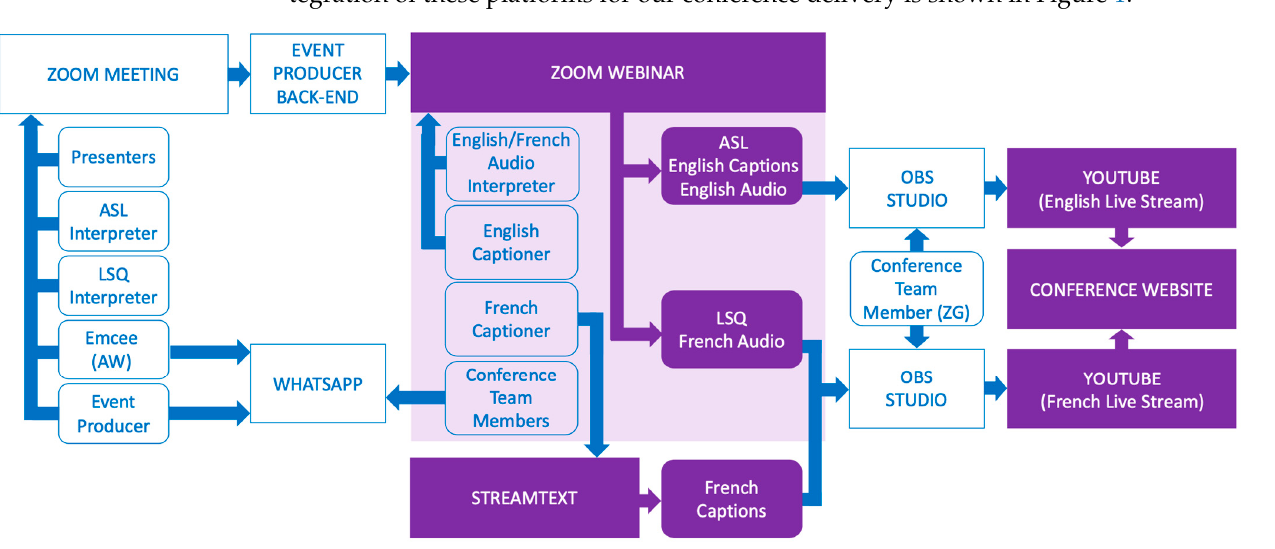
Figure 1. This diagram shows the platforms (Zoom Meeting, Zoom Webinar, StreamText, YouTube, WhatsApp, and OBS Studio), individuals, and interpretation/accessibility features that were needed to deliver our conference and how they were connected. The platforms and elements that the audience was able to access are indicated in purple.